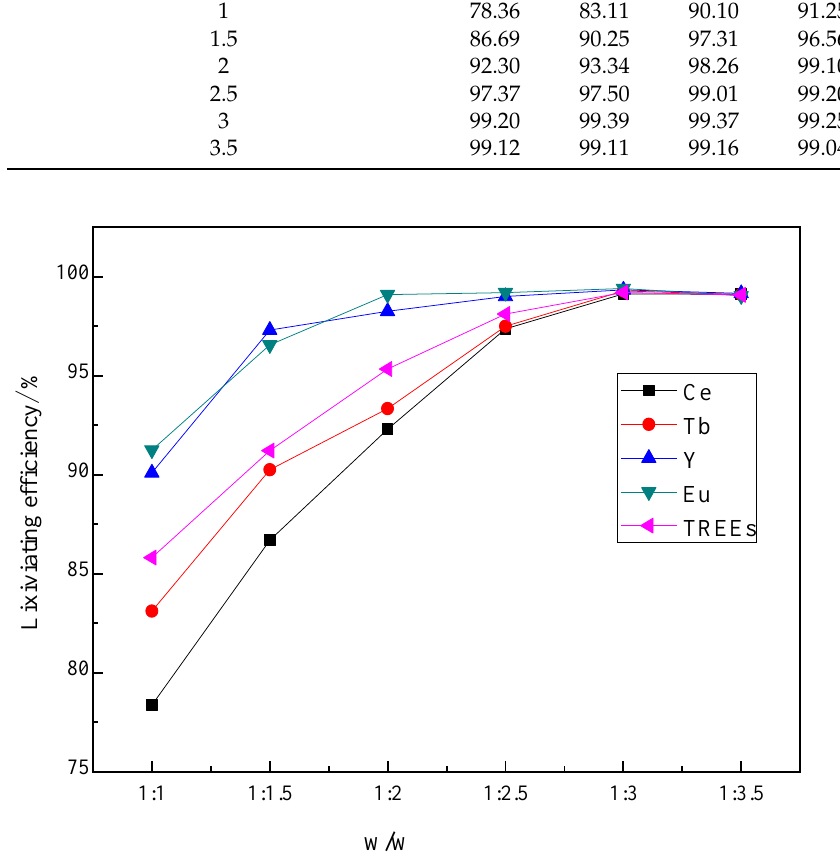
Figure 9. Influence of the mass ratio on the REEs leaching efficiencies (oxygen concentration in the mixed gas of 0.4%, roasting temperature of 700 ◦ C, roasting time of 2.5 h, HCl solution concentration of 8 mol · L − 1 , acid leaching temperature of 60 ◦ C, acid leaching time of 1 h, and liquid–solid ratio of 10:1). From Figure 9, the REEs leaching efficiencies increased with decreasing mass